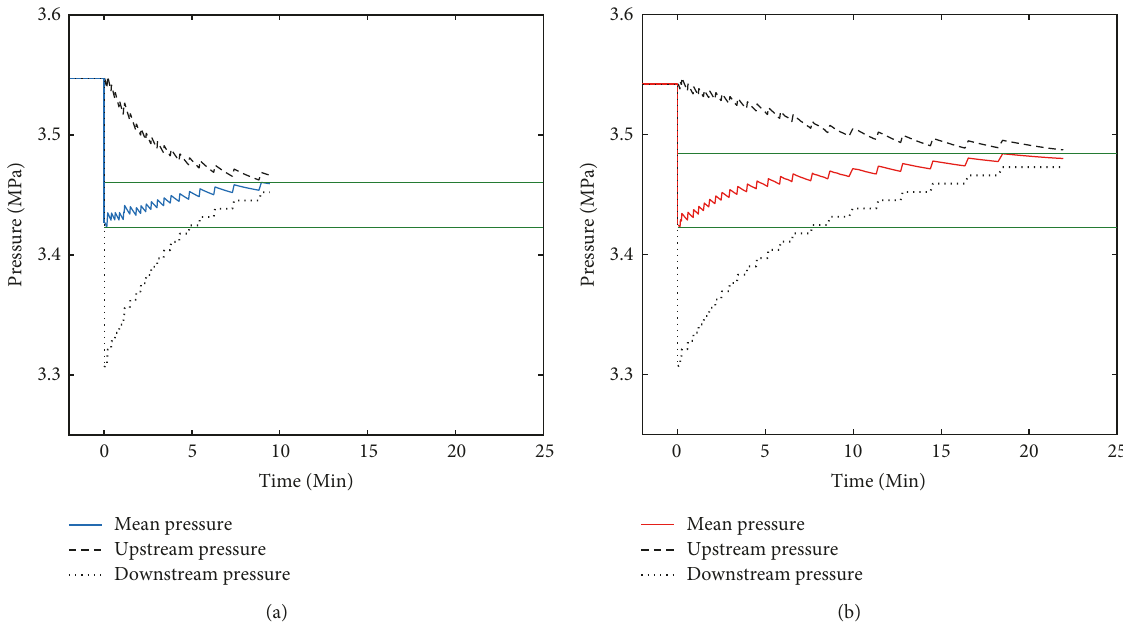
Figure 4: Comparison of helium (a) and ethane (b) pulse decay data for sample B5FD2A2. Mean pore pressure increases throughout the helium permeability measurement because the upstream reservoir of the permeameter is larger than the downstream reservoir, and gas was bled from the downstream reservoir to generate the differential pressure. Mean pore pressure increases by more in the ethane measurement than the helium measurement because liquid/semiliquid ethane desorbs to reach equilibrium at the final gas pressure, which is lower than the equilibrium gas pressure during the soak period (time < 0 on graphs). Differential pressure in the ethane permeability measurement takes more than twice as long to decay than the helium differential pressure because adsorbed liquid/semiliquid ethane constricts flow paths resulting in lower ethane gas permeability. Green lines indicate the difference between minimum mean pressure and final equilibrium